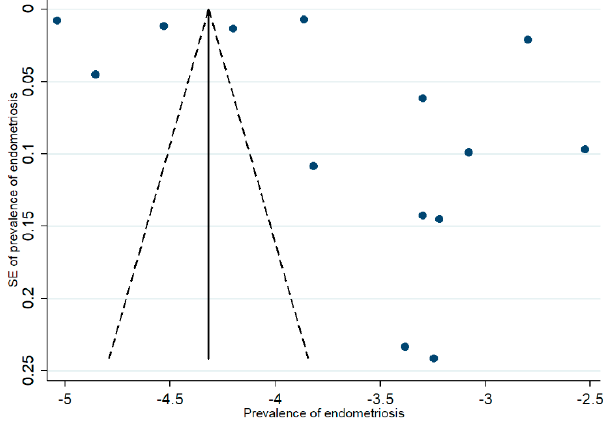
Figure A1. Funnel plot for prevalence data. Note: blue dots represent individual studies; the outer dotted line indicates the triangular region within which 95% of studies are expected to lie in the absence of both biases and heterogeneity; the solid vertical line represents the line of no effect, derived using fixed-effect meta-analysis.